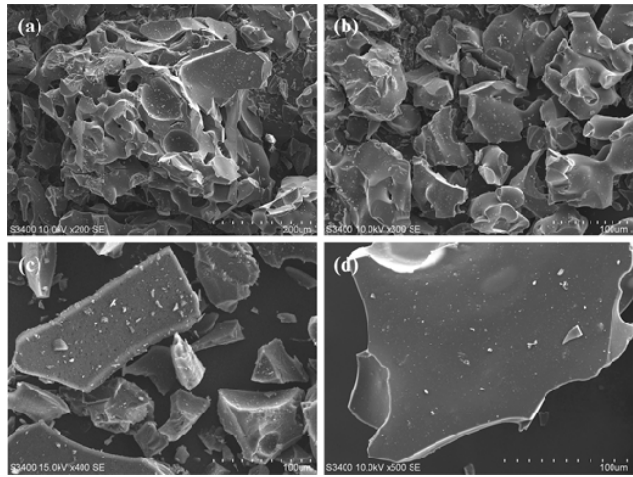
Figure 6. The SEM images of GMC samples. ( a ) GMC sample prepared in a tubular furnace at 800 ◦